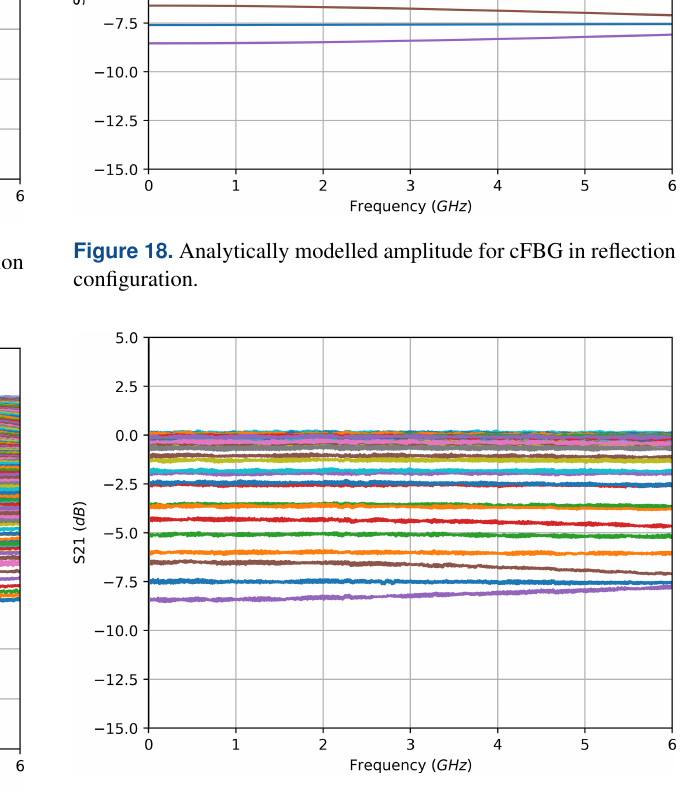
Figure 17. Measured amplitude for FBG in reflection configura- tion.